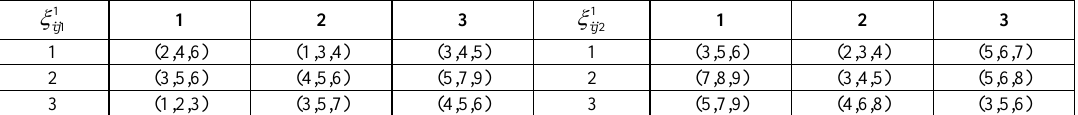
Table 1. The shipping costs for the two conveyances train and cargo ship.